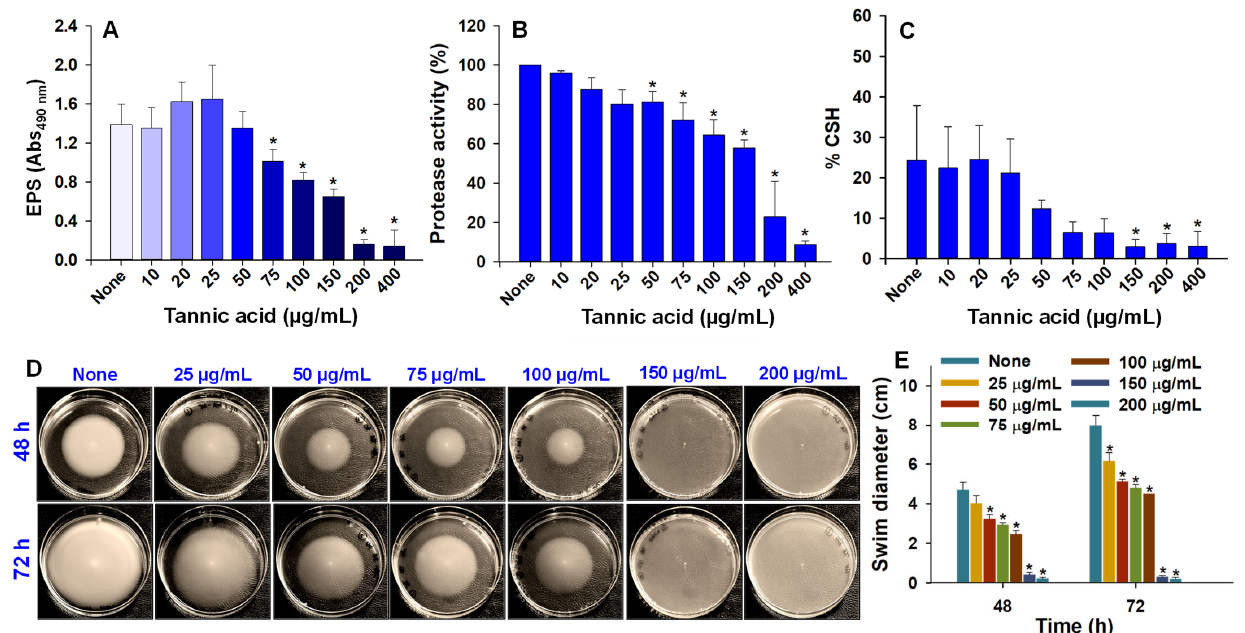
Figure 5. Tannic acid concentration-dependent decrease in the virulence traits of A. tumefaciens . Exopolysaccharides (EPS) production ( A ), protease activity ( B ), and percent cell surface hydrophobicity (%CSH) ( C ) after incubation at 250 rpm for 24 h at 30 ◦ C in LB. Concentration-dependent effect of tannic acid on the swimming motility of A. tumefaciens ( D ) after incubation for 48–72 h tannic acid containing peptone agar (1% peptone, 0.5% NaCl, 0.25% agarose). Swim diameters were recorded after incubation for 48 or 72 h ( E ). For EPS production, protease activity, and %CSH, two independent bacterial colonies were used in triplicates ( n = 6) and experiments were repeated twice. For swimming motility, three independent colonies were used ( n = 3), and experiment was repeated twice. Asterisks denote significant differences between nontreated and treated A. tumefaciens . p ≤ 0.05 by the two ‐ tailed t ‐ test.